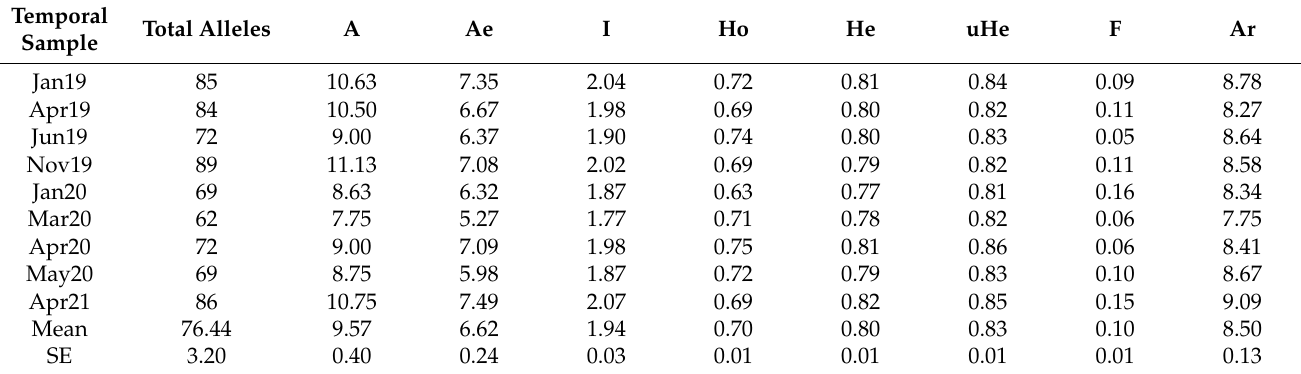
Table 5. Genetic diversity indices of eight microsatellite markers in nine temporal